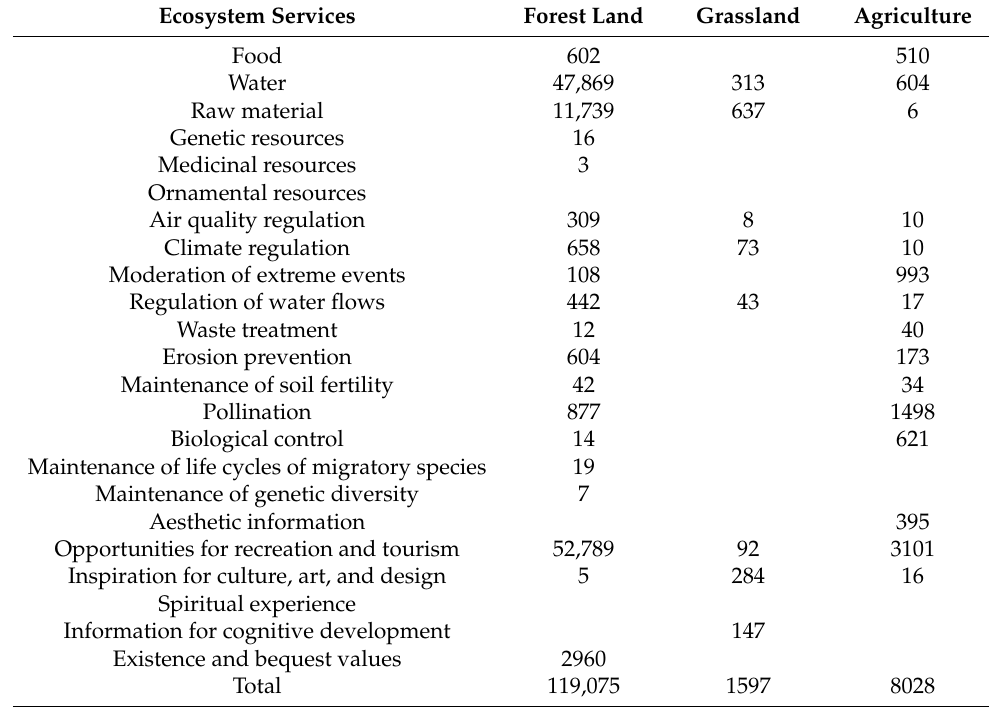
Table 4. Land uses and the associated individual ecosystem service values (in US million dollars per hectare per year at 2020